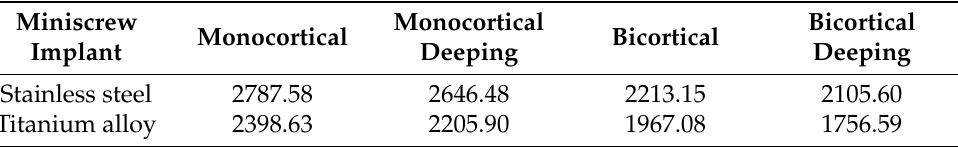
Table 2. Mean von Mises stress (MPa) of the peri-implant bones for the skull. Model with midpalatal suture for all 4 anchorage